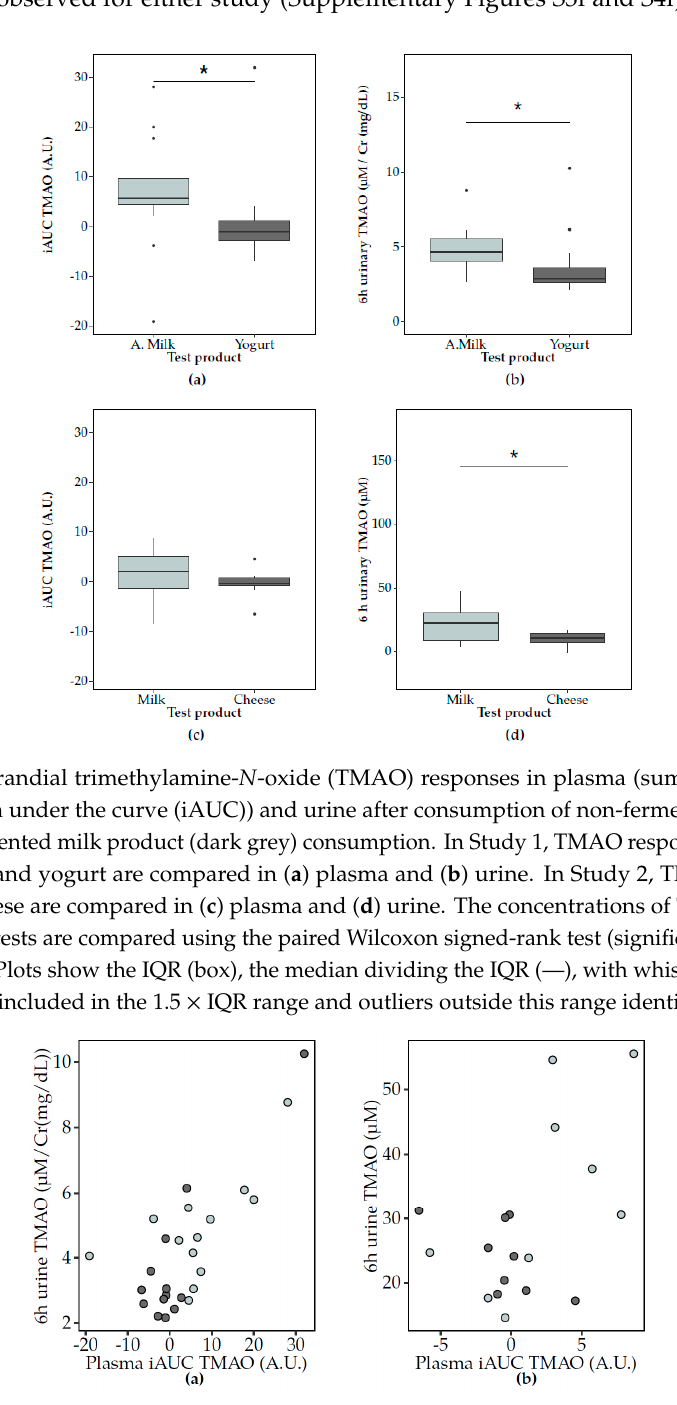
Figure 3. Scatter plots to illustrate the association between the postprandial TMAO changes in plasma (iAUC) and urine (6 h pool) after non-fermented milk (light grey) and fermented dairy (dark grey) consumption. Spearman’s correlation test showed positive associations between postprandial TMAO (iAUC) in plasma and urine (6 h pool) in Study 1 ( a ) (acidified milk, rho = 0.48, p = 0.02; yogurt, rho = 0.39, p = 5 × 10 − 5 ) and after milk consumption in Study 2 ( b ) (milk, rho = 0.52, p = 0.15; cheese, rho = 0.11, NS). Significant associations at p < 0.05. iAUC, incremental area under the curve; TMAO, trimethylamine- N -oxide; Cr, creatinine.